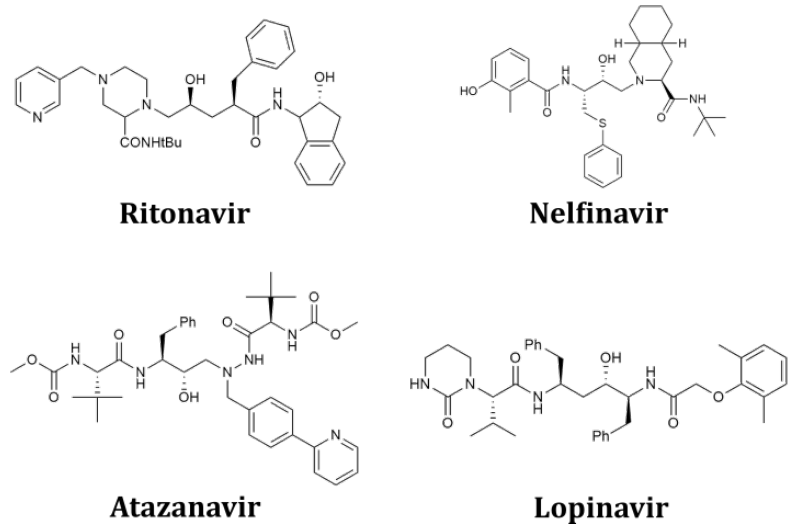
Figure 1. Structures of the clinically used HIV-1 inhibitors that were predicted to bind the 3CL pro main protease of SARS-CoV-2 and formed the design starting point.